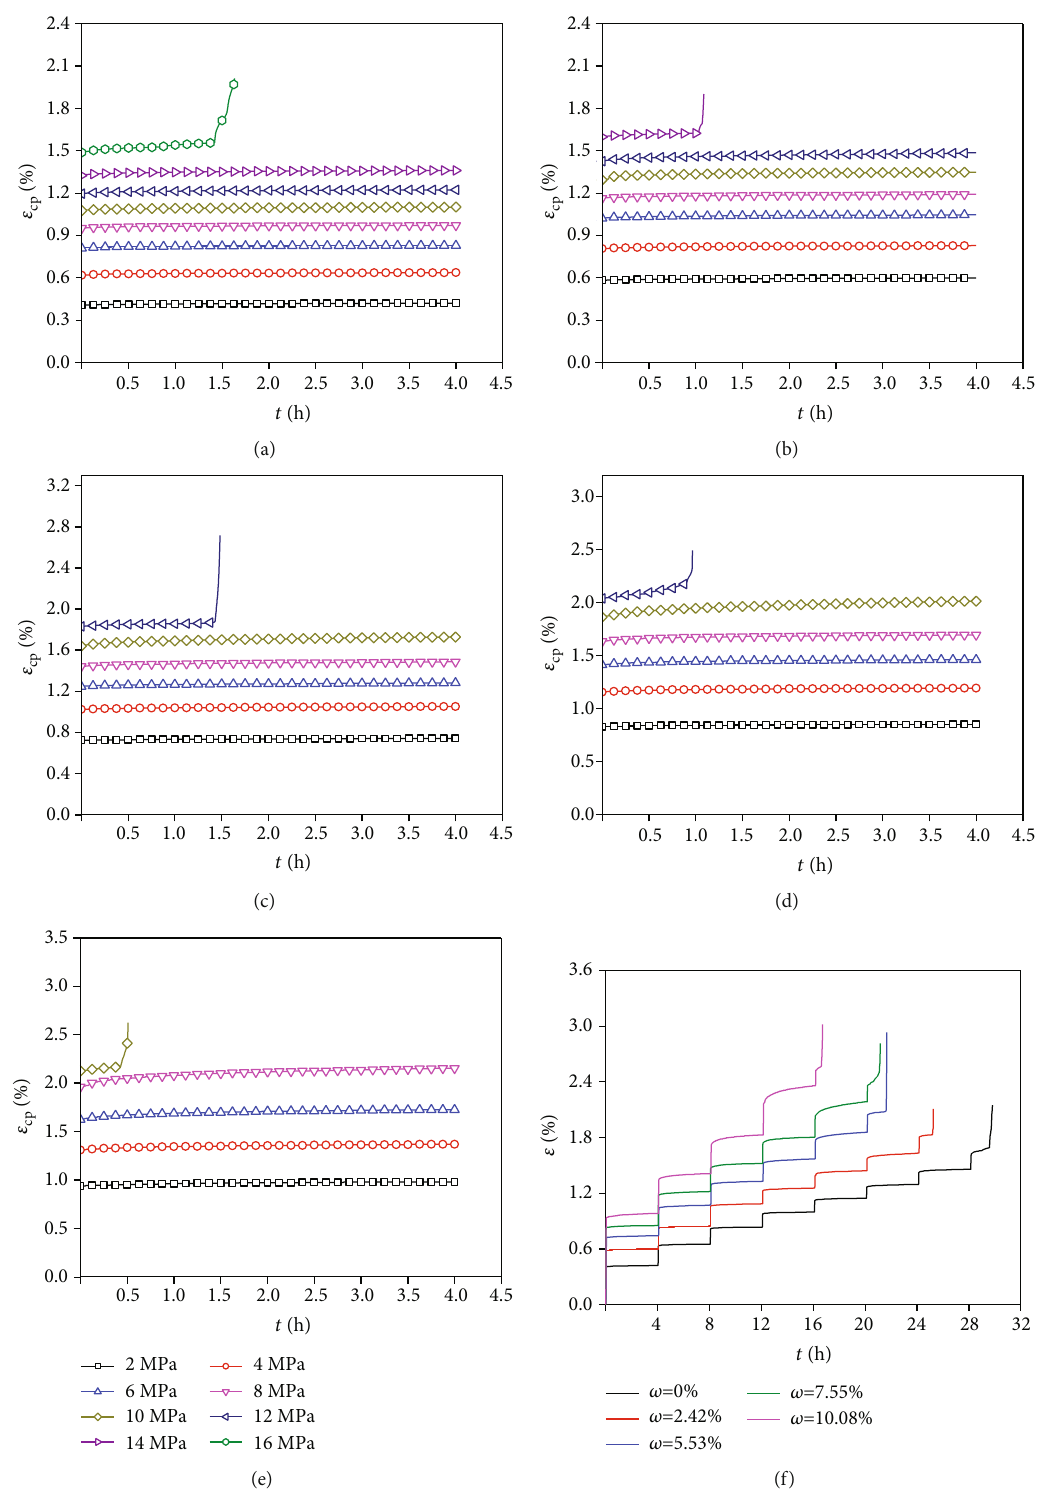
Figure 5: Time-history curves of creep and strain of coal specimens at di ff erent moisture contents: (a) ω = 0 % , (b) ω = 2 : 42 % , (c) ω = 5 : 53 % , (d) ω = 7 : 55 % , and (e) ω = 10 : 08 % . (f) Summary of strain time-history curves under di ff erent water